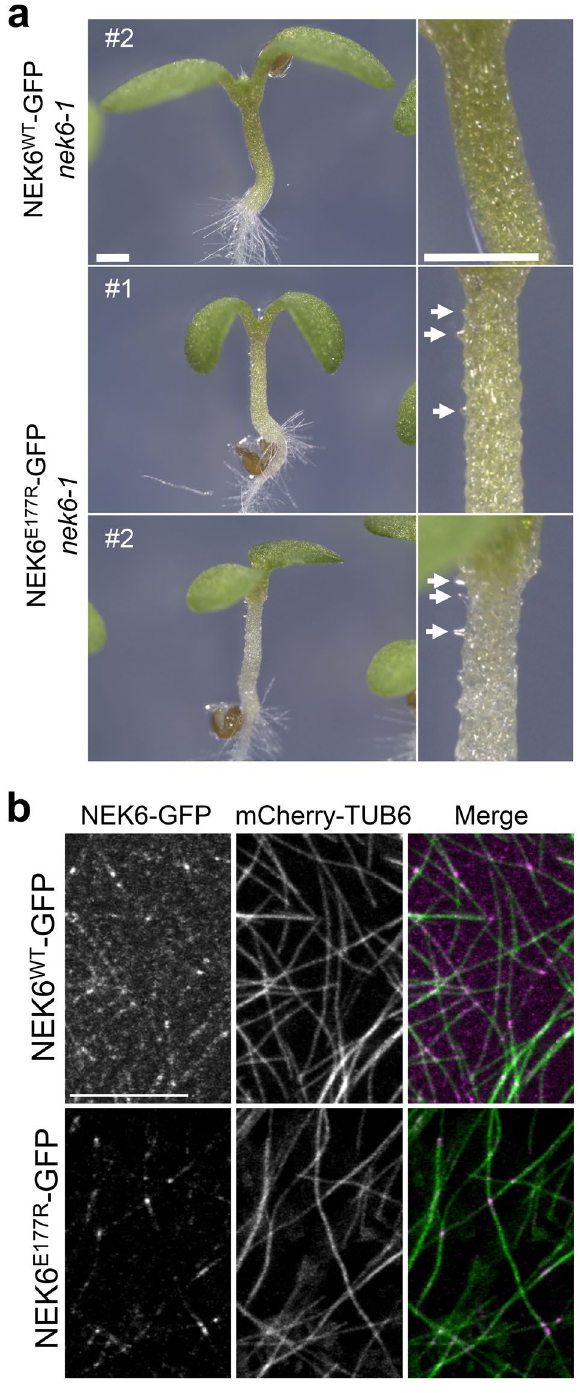
Figure 8. NEK6 kinase activity is essential for directional cell growth. ( a ) The ectopic outgrowth phenotype is complemented by expressing the wild type NEK6 (WT) but not by expressing the kinase-dead NEK6 (E177R). The scale bars represent 0.5 mm. ( b ) Subcellular localization of wild type NEK6 (WT) and kinase-dead NEK6 (E177R) proteins fused with GFP at the C-terminus (magenta). Cortical microtubules are visualized with mCherry-TUB6 (green). RFP signals are shown in green and GFP signals are shown in magenta. The scale bar represents 10 µ